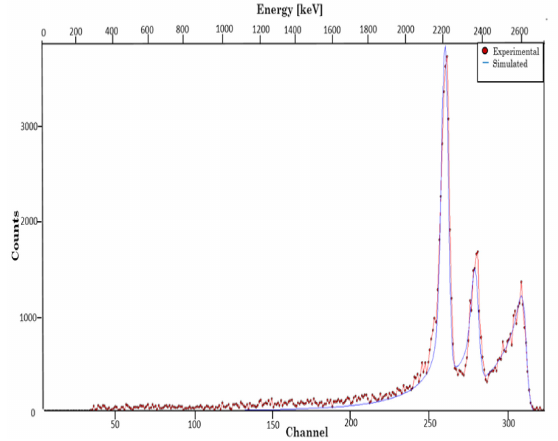
Fig. 3. EBS spectra obtained using the SIMNRA simulations comparing with experimental